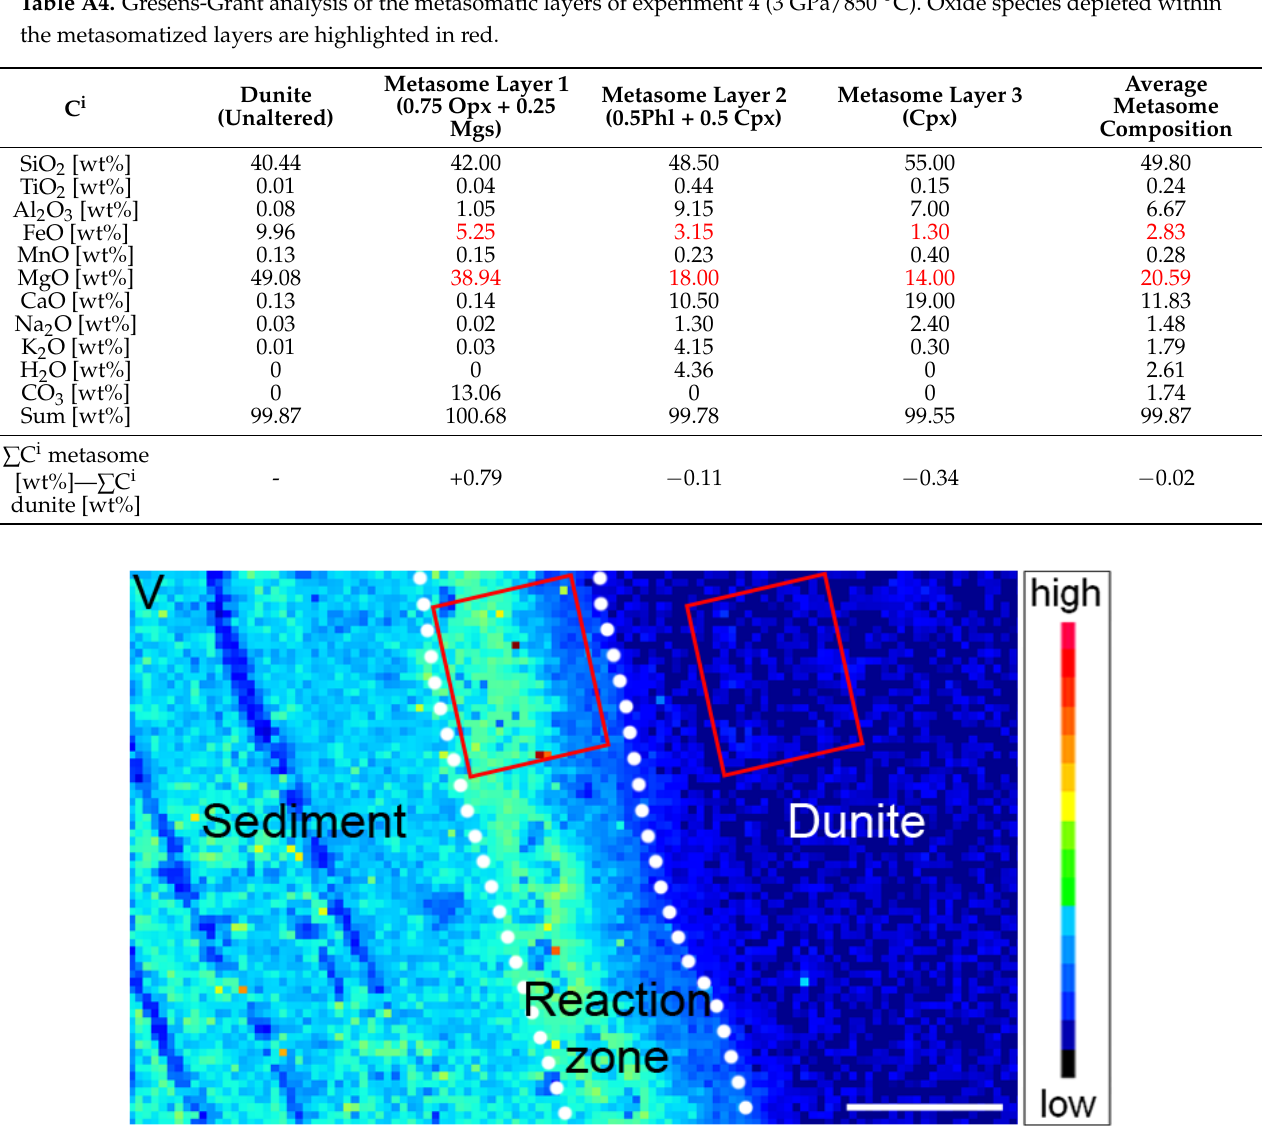
Figure A5. LA-ICP-TOFMS map of vanadium. Scale bar corresponds to 100 µm. The map depicts two areas of 10,000 µm 2 within the reaction zone and within the dunite. The location of the marked area is chosen to represent the most homogeneous part of the reaction zone, while cracks and holes disturb the image in the lower half. The count rates were taken from both areas and used to calculate the enrichment factor of the reaction zone.